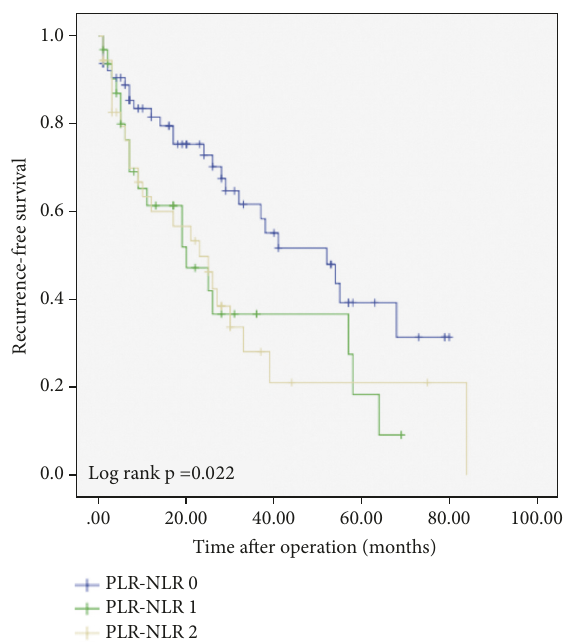
Figure 1: Kaplan–Meier survival plots comparing overall survival for patients with preoperative NLR-PLR score of 0, 1, and 2.